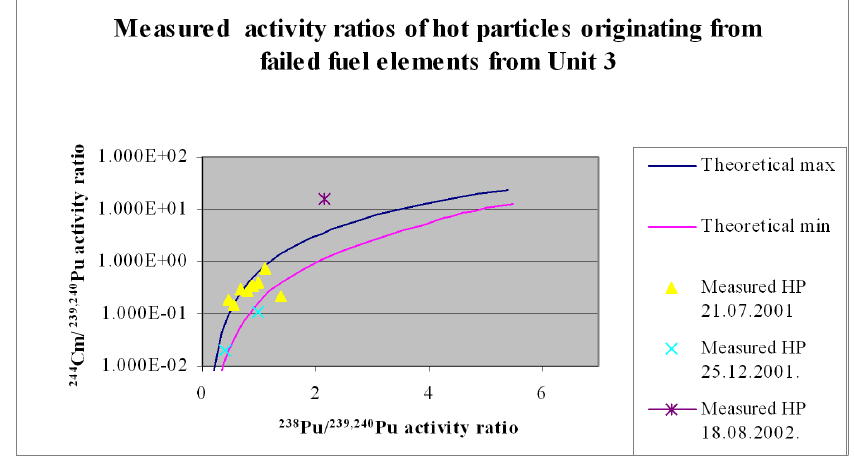
Fig. 7 Measured activity ratios of hot particles originating from failed fuel elements from Unit